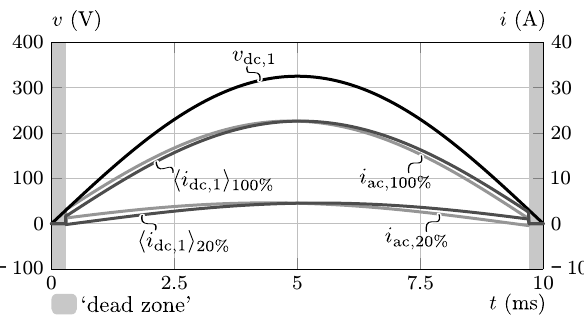
Figure 2. Ideal ac input-side quantities v dc,1 , i ac , and (cid:104) i dc,1 (cid:105) within a 10 ms half period of the grid voltage v ac for I ac = I ac,nom = 16 A rms (100% power) and I ac = 0.2 · I ac,nom = 3.2 A rms (20%